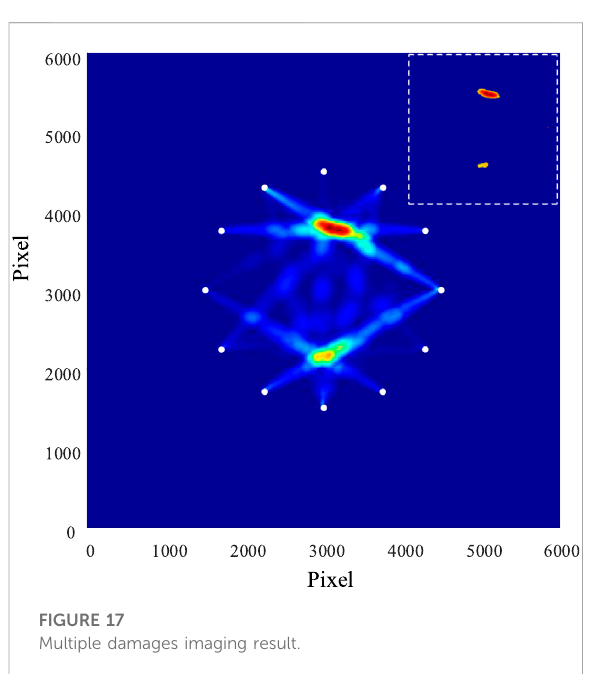
FIGURE 17 Multiple damages imaging